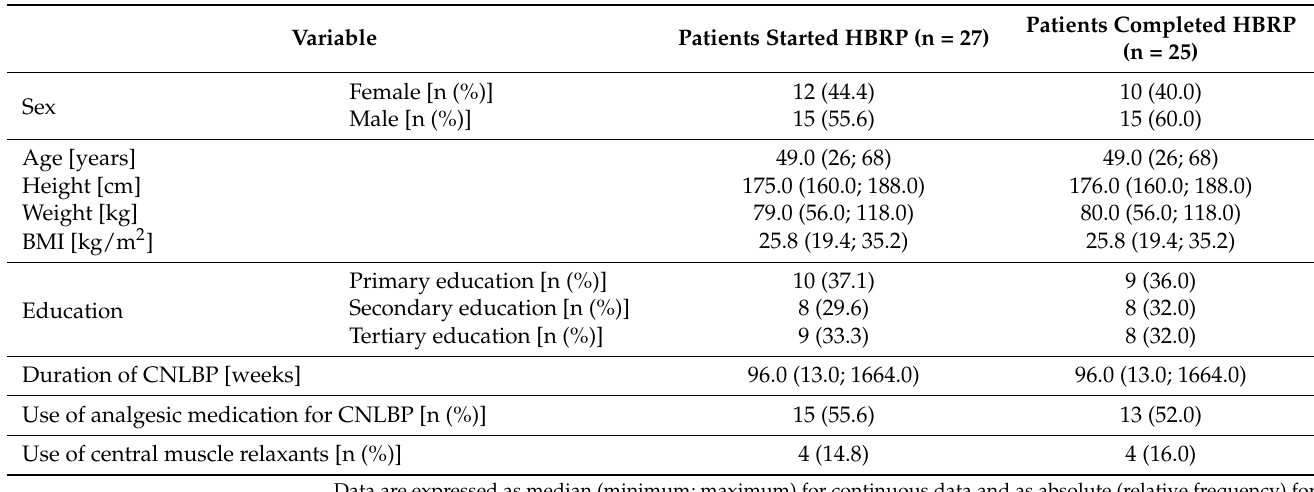
Table 1. Characteristics of subjects.